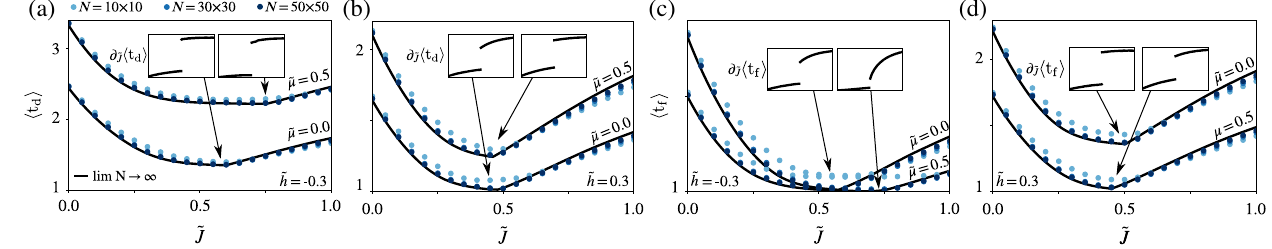
˜ J for a pair of intrinsic affinities ˜ μ ¼ 0 and ˜ μ ¼ 0 . 5 and [Eqs. (6) and (8)] and ¯ w from Eq. (E18) with k → k þ 1 k